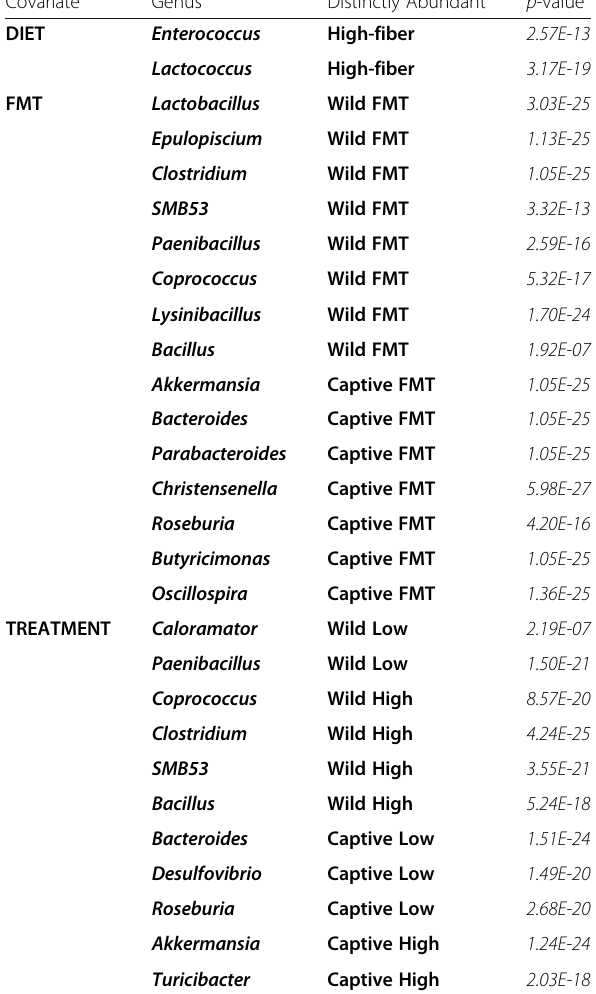
Table 1 Differentially relatively abundant genera discovered using Kruskal-Wallis test and False Discovery Rate correction.